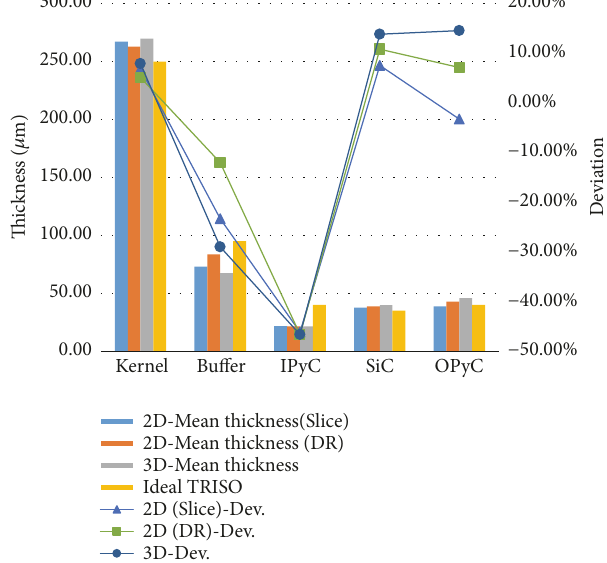
Figure 9: Comparison between 2D and 3D measurement of thickness and design thickness of